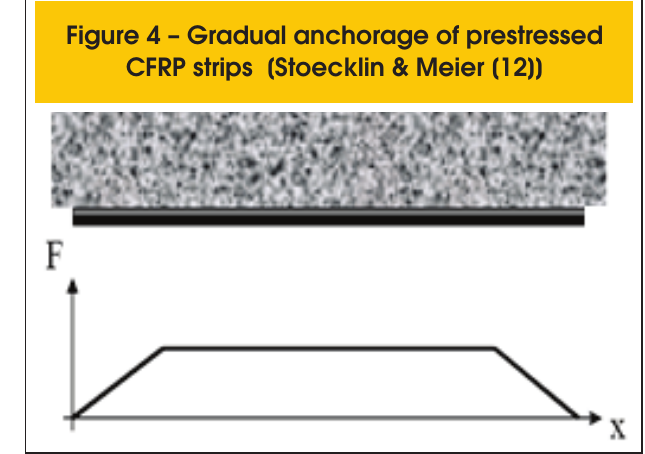
Figure 4 – Gradual anchorage of prestressed CFRP strips [Stoecklin & Meier